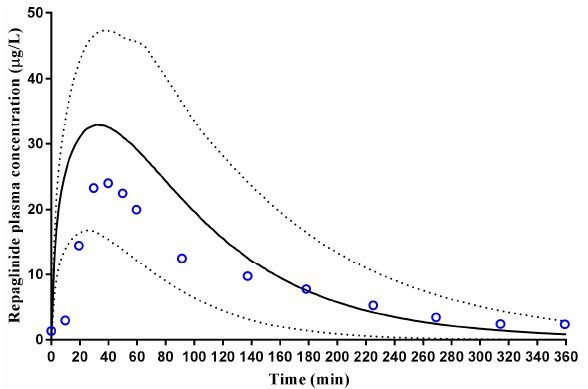
Figure 4. Simulated plasma concentration–time profile of repaglinide in healthy adults. A 2 mg oral dose of repaglinide was administered once daily to healthy adult volunteers ( n = 24). Solid lines represent mean population prediction with dotted lines representing 5th and 95th percentile ranges. Open circles represent data for the observed study [42].